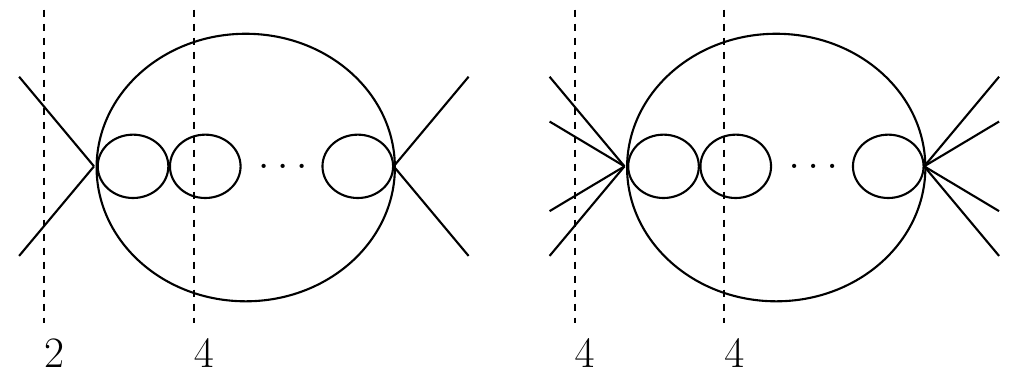
Figure 2 . Left: renormalon type diagrams in 2-particle scattering violate particle number conser- vation. Right: in 4-particle scattering particle number can be